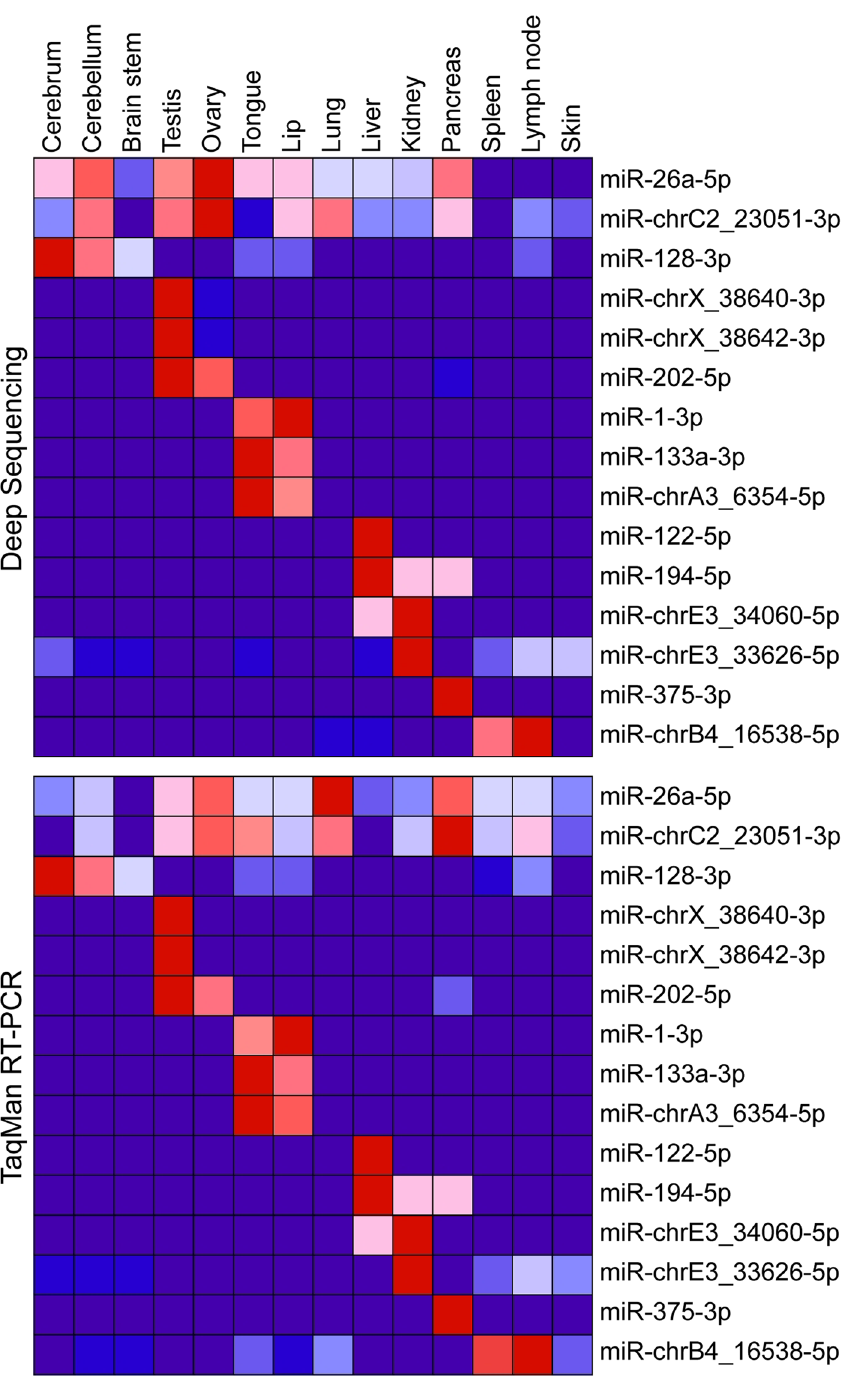
injury and whose down-regulation is thought to be crucial in the development of pancreatic cancer 30 ; miR-150, which our analysis reported as enriched in lymph nodes, is known to be expressed in mature B and T cells and,